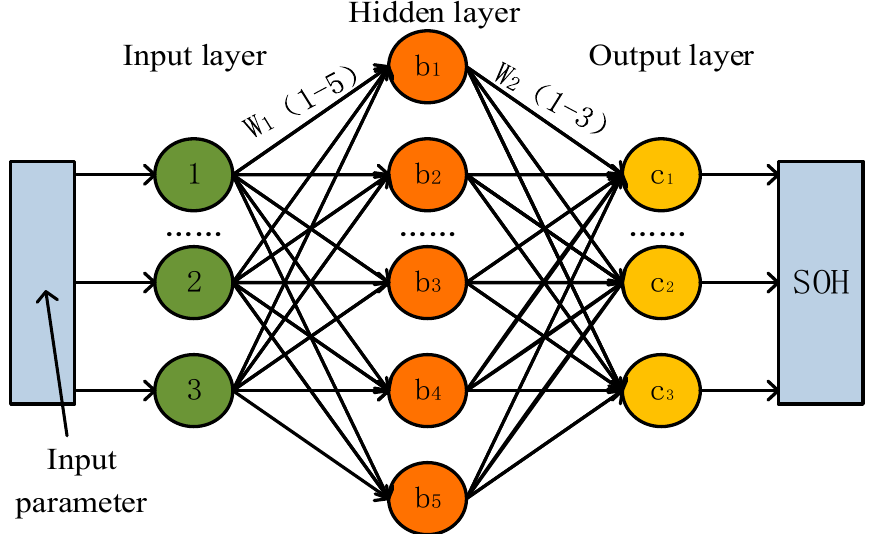
Figure 4. Typical artificial neural network